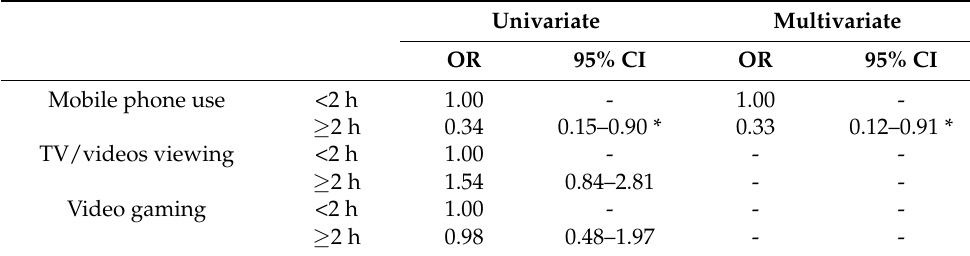
Table 2. Univariate and multivariate logistic models assessing the effects of each screen time on 2 years change in